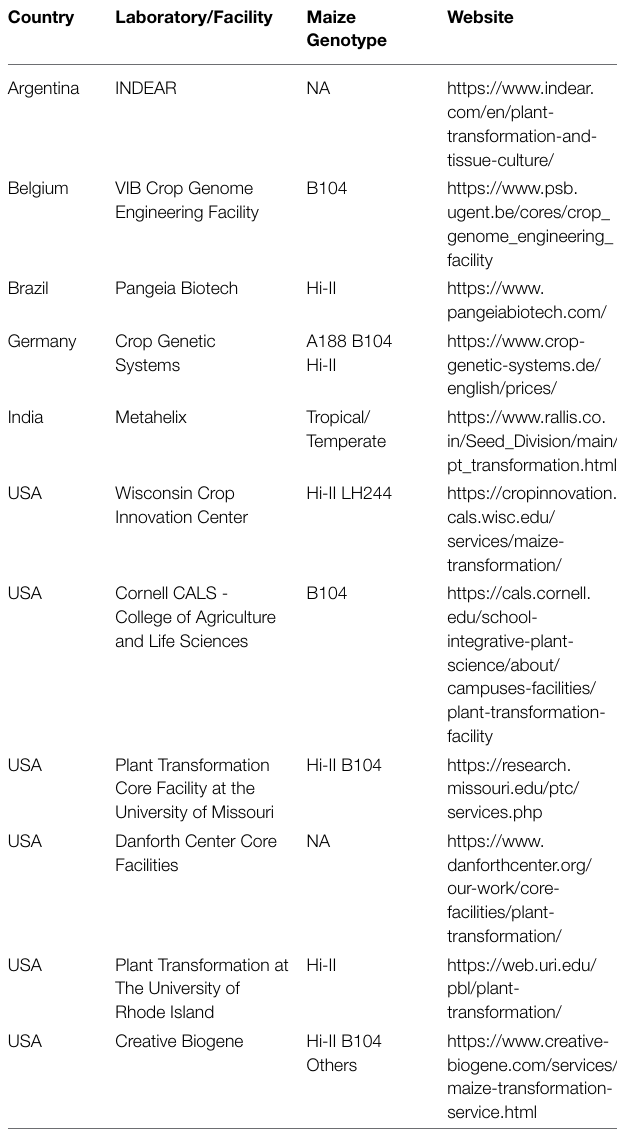
TABLE 1 | Academic laboratories and facilities providing maize transformation